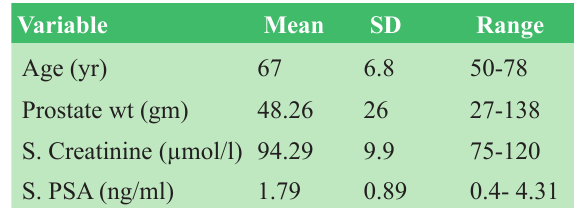
Figure 1. Visual Prostate Symptom Score